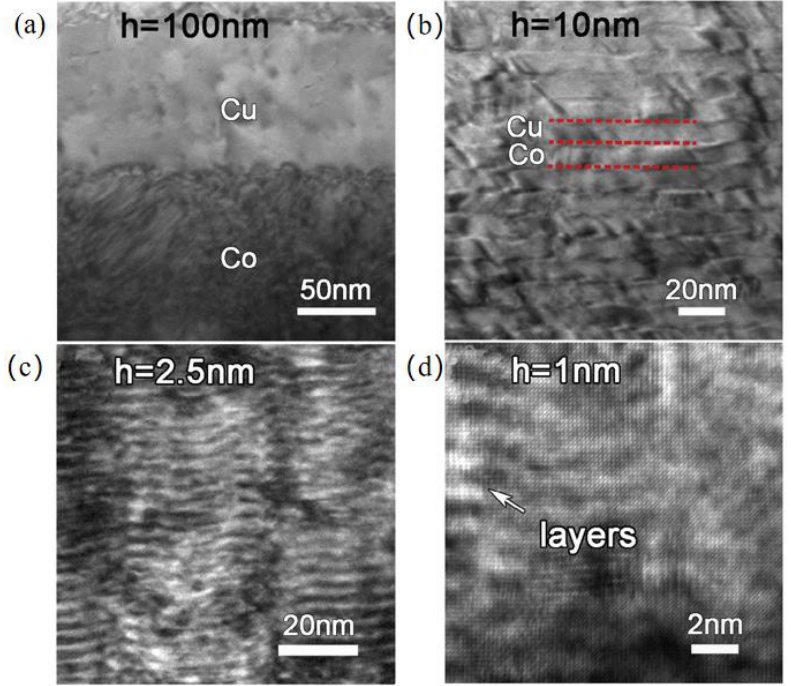
Figure 7. The relationship between defect density and layer thickness of as-deposited Cu/Co multilayer films. The density of the defects declines with decreasing layer thickness. There are high-density stacking faults in multilayer films with layer thickness of ( a ) 100 nm, few in ( b ) 10 nm, and none in ( c ) 2.5 nm and ( d ) 1 nm [76]. Reprinted with permission from [72] Elsevier 2018.